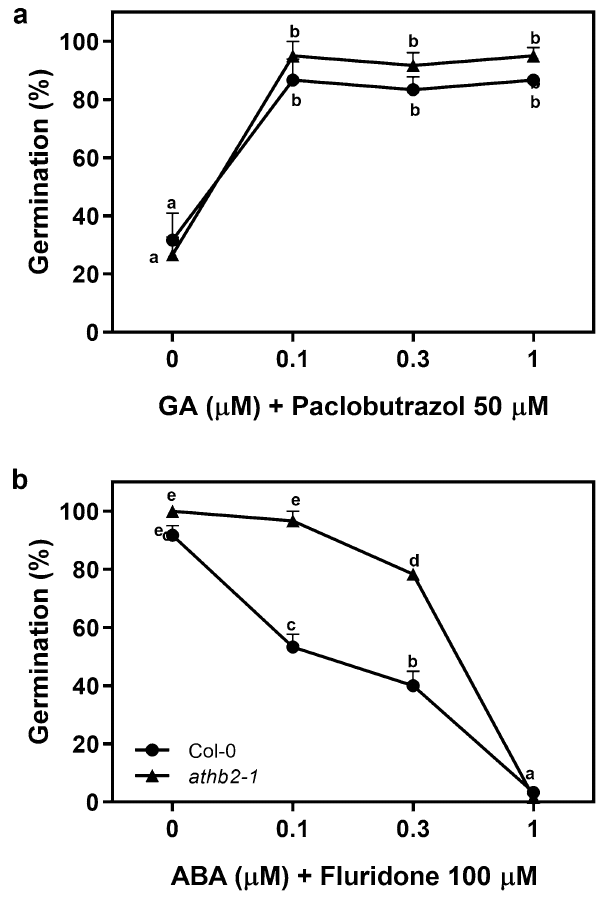
of 50 uM paclobutrazol; and ( b ) ABA, in the presence of 100 uM fluridone. Each point represents mean ± SE (n ≥ 6). Significant differences between means are shown with different letters ( p < 0.05 by ANOVA followed by Fisher post